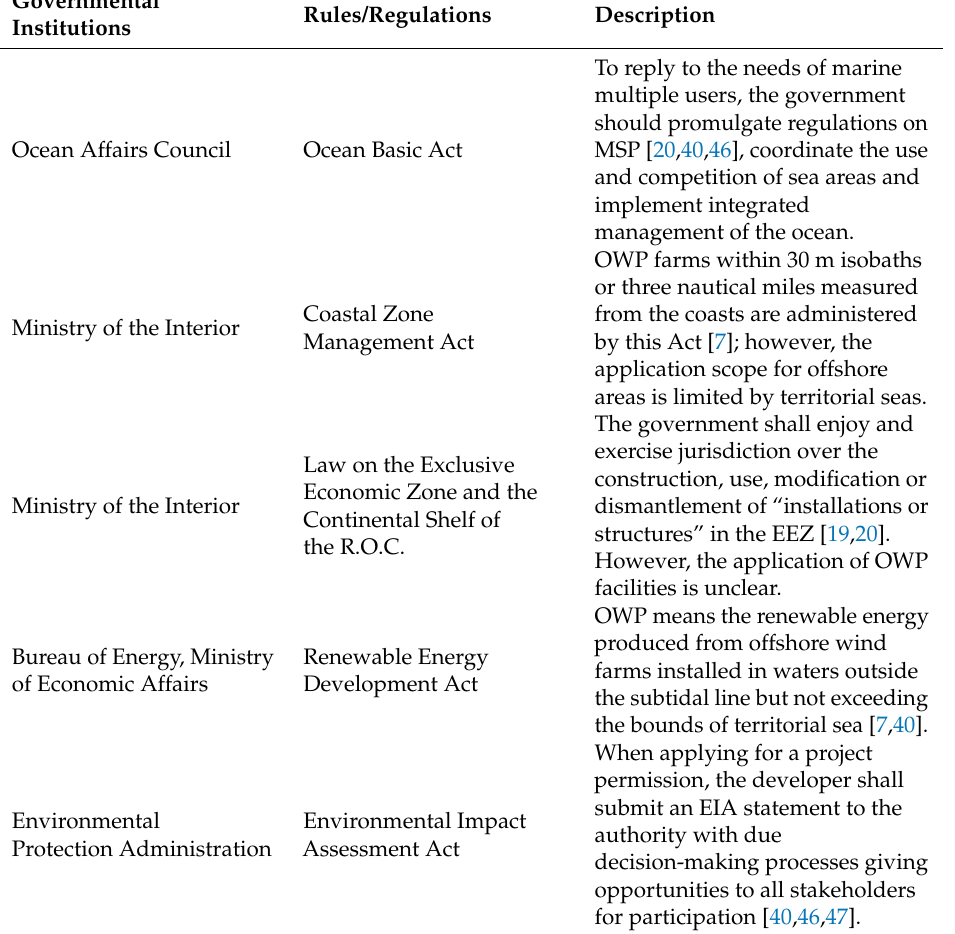
Table 1. Summary of the governmental institutions related in OWP management and MSP in